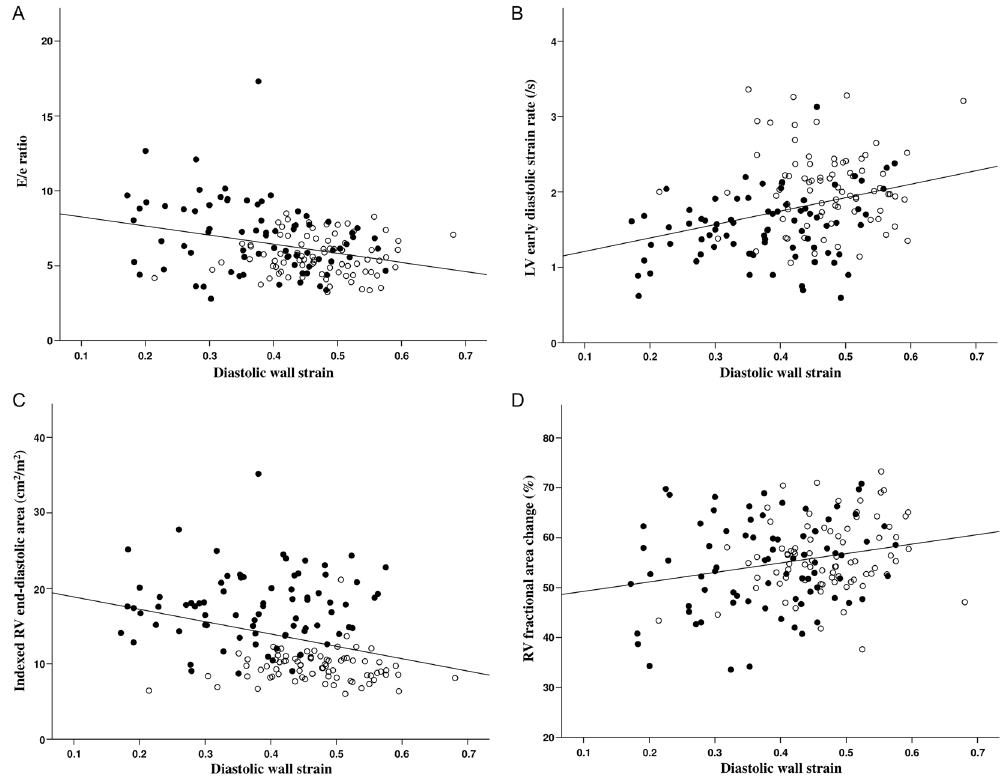
Figure 2. Scatterplots showing the relationships between left ventricular diastolic wall strain and ( A ) the ratio of transmitral early diastolic flow velocity ( E ) to mitral annular early diastolic velocity (e), ( B ) left ventricular (LV) early diastolic strain rate, ( C ) indexed right ventricular (RV) end-diastolic area, and ( D ) RV fractional area change. Solid circles represent patients, empty circles represent